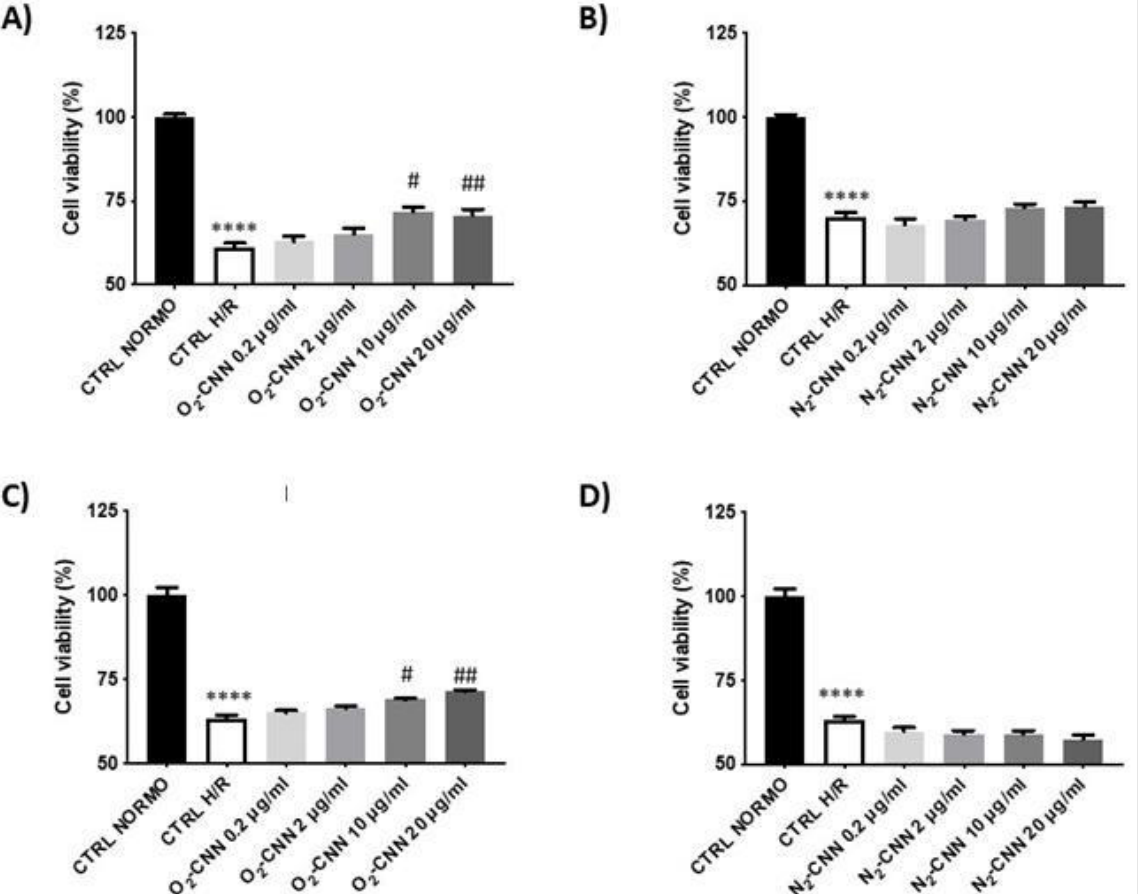
Figure 6. CNN pre-treated cells in H/R conditions. ( A , B ): O 2 - and N 2 -CNN pre-treated H9c2 in H/R conditions. ( C , D ): O 2 - and N 2 -CNN pre-treated HMEC in H/R conditions. **** p < 0.0001 vs. CTRL NORMO; # p < 0.01 vs. CTRL H/R; ## p < 0.0001 vs. CTRL H/R. Data were expressed as mean ± SE. Data were normalized to the mean value in control conditions (CTRL NORMO) and expressed as a percentage.